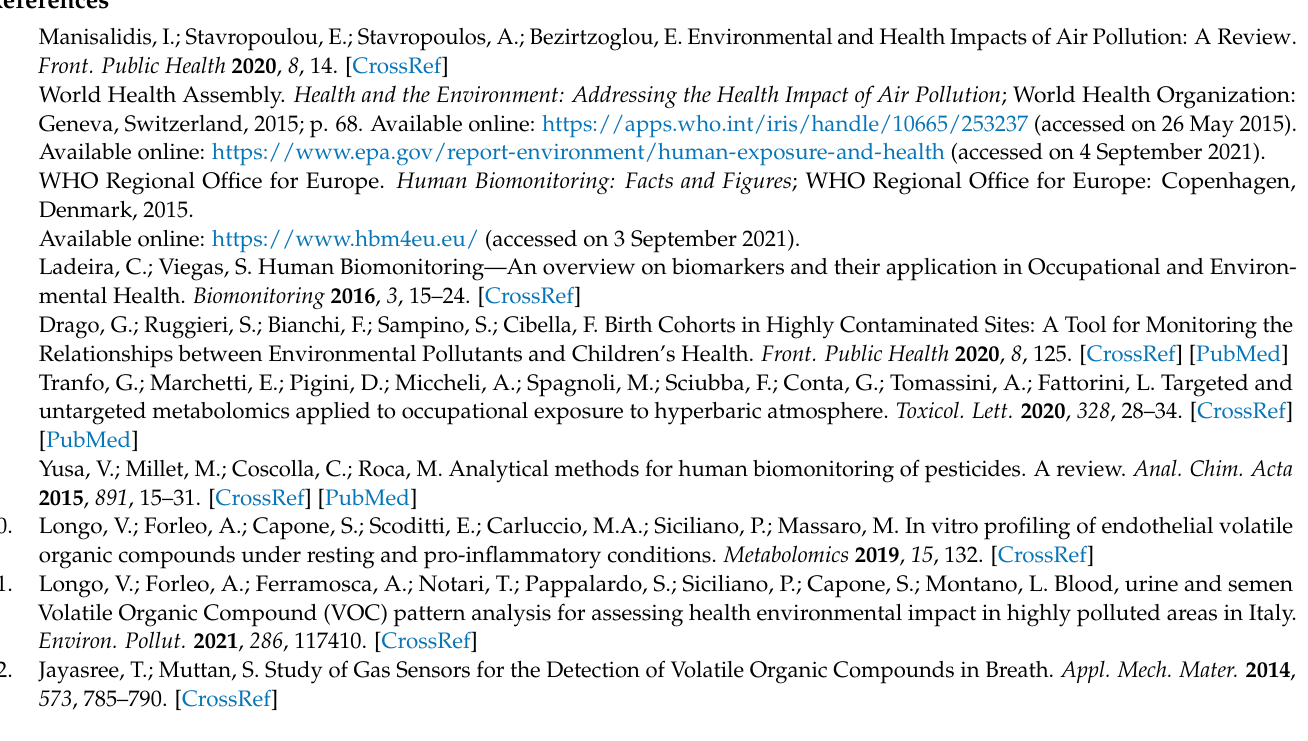
Pollutants (POPs), Table S2: Summary of included studies concerning Volatile Organic Compounds (VOCs), Table S3: Summary of included studies concerning pollutants different from POPs and VOCs, Table S4: Summary of included studies in which gas sensors are used for VOC